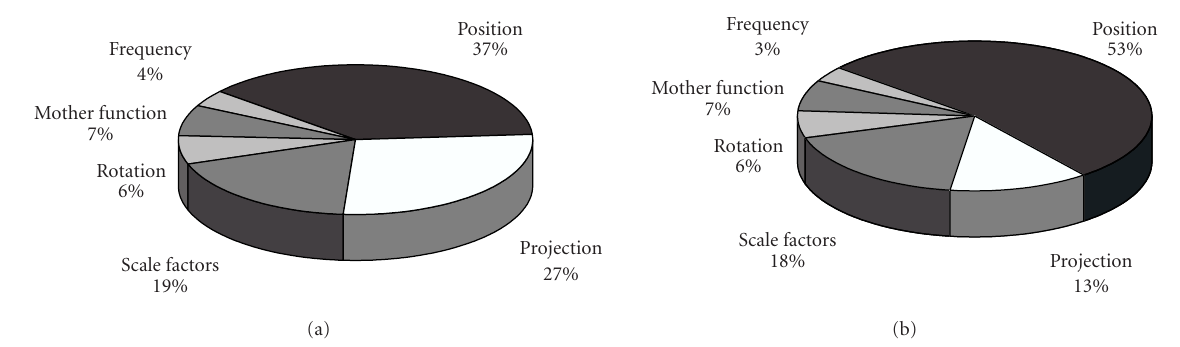
Figure 4: Example of typical bit allocations for (a) position and (b) projection DPCM encoding styles.